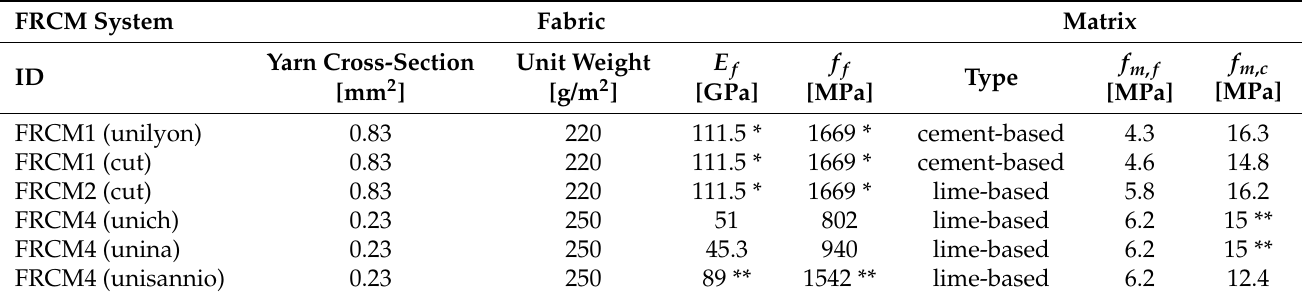
Table 1. Mechanical properties of material constituents.